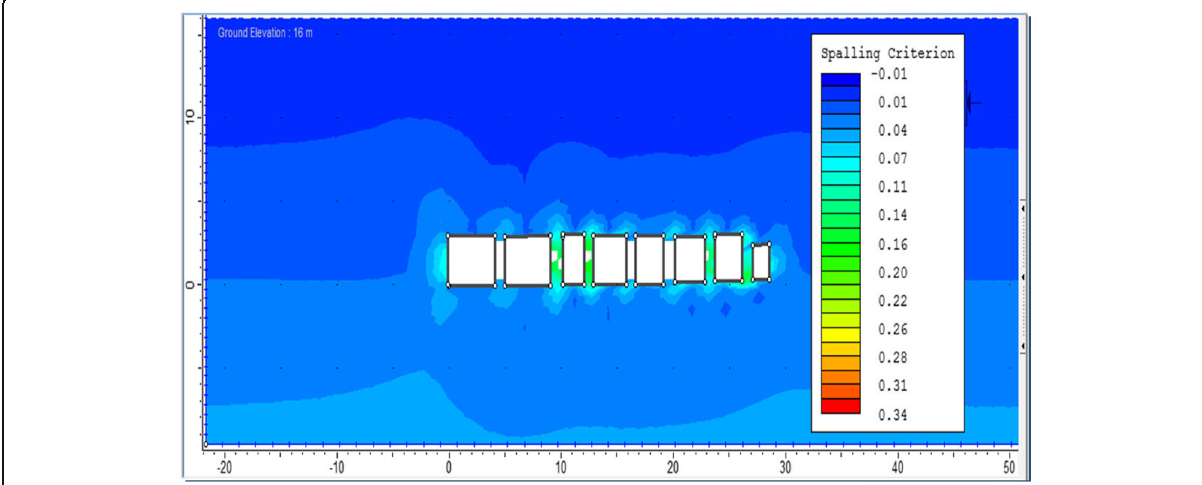
Fig. 14 Spalling Criterion through the rock pillars in Chamber 3. Examine